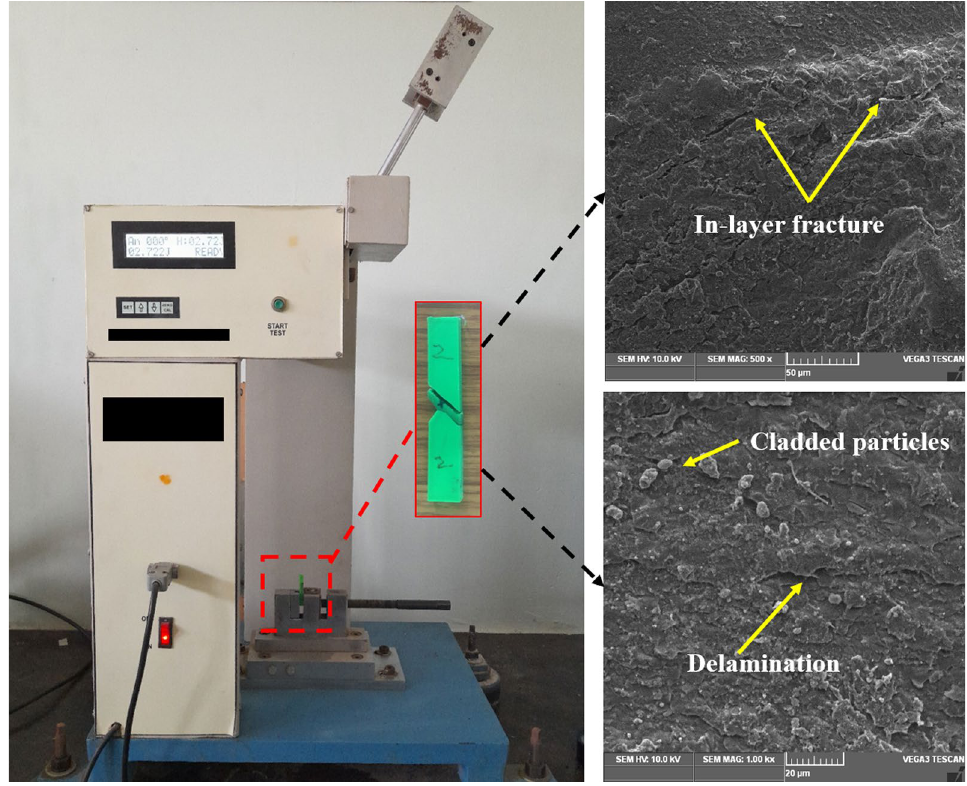
Figure 13. Printed PLA (Izod) impact specimen under optimum input parameters and fractured